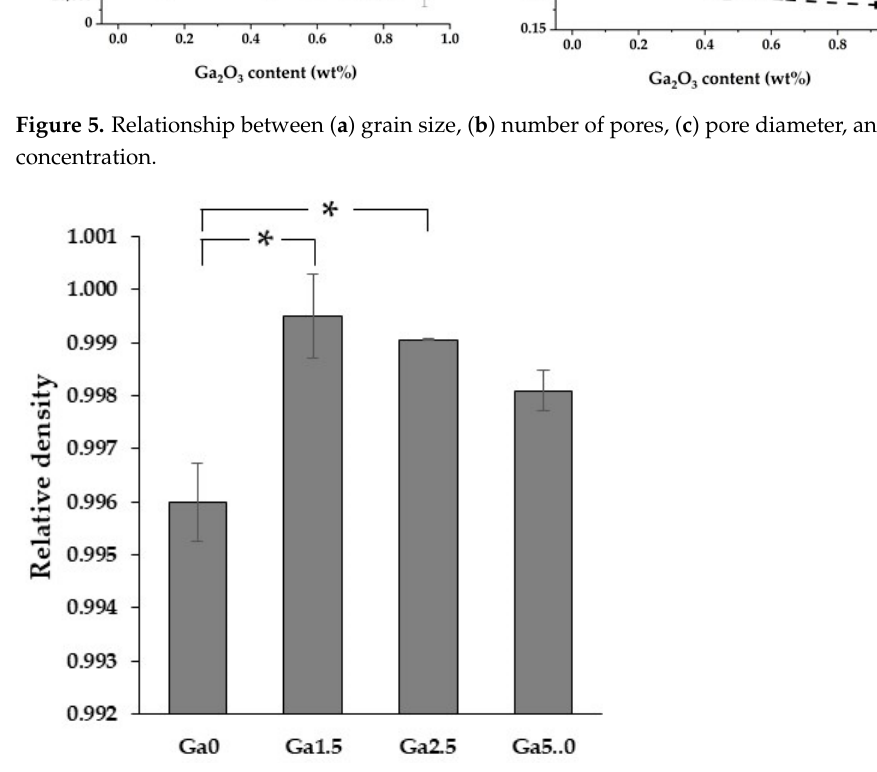
Figure 6. Relative densities of each sample. The asterisk refers to statistical significance according Tukey-Kramer multiple comparison to Tukey-Kramer multiple comparison test.